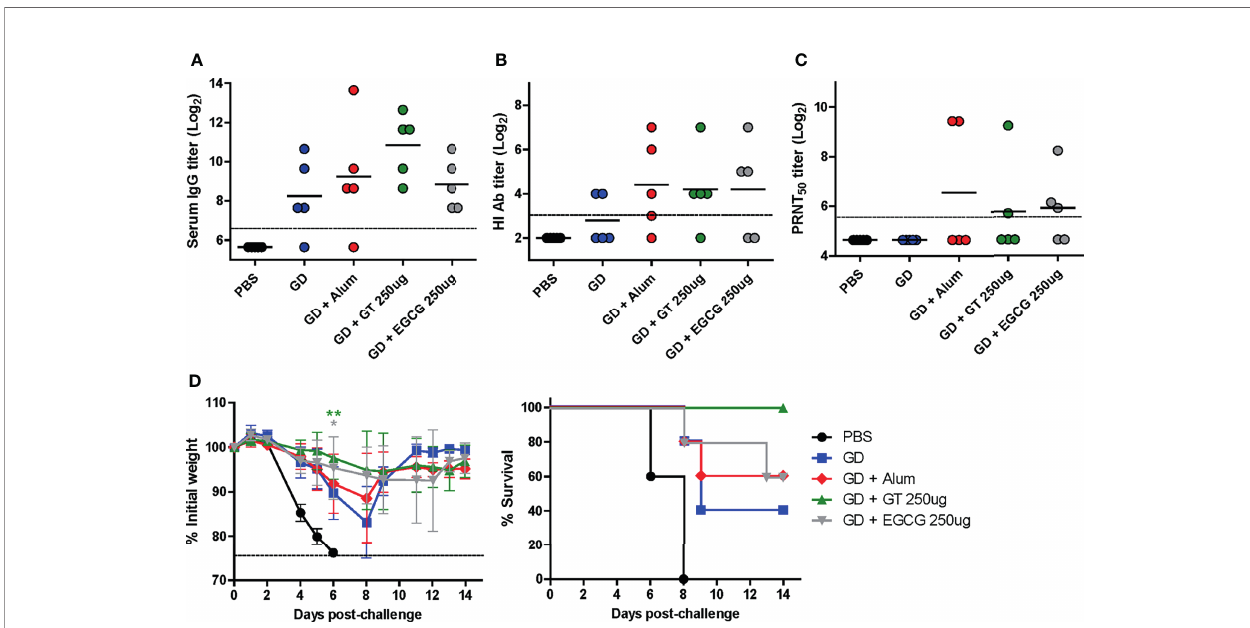
FIGURE 2 | Adjuvant effect of GT or EGCG on recombinant HA GD antigen. PBS or 10 µg of GD antigens with or without alum, GT, or EGCG were injected into mice via IM route thrice with the interval of two weeks. The overall experimental schedule was the same as presented in Figure 1B . (A) IgG antibody response to in fl uenza PR8 virus. The antibody titer of each sample was expressed as the endpoint dilution with an absorbance value 2× greater than that of the PBS control group. The detection limit (dashed line) was 100. (B, C) Neutralizing antibody responses to in fl uenza PR8 virus. HI antibody titers (B) and PRNT 50 titers (C) against the PR8 virus are shown. The detection limits of the HI assay and PRNT (dashed lines) were 8 and 50, respectively. (D) Protective ef fi cacy against in fl uenza PR8 virus. The vaccinated mice were challenged with 2 × 10 3 PFU (2 MLD 50 ) of wild type PR8 virus after the last vaccination, and the changes in weight and survival rates of the mice were monitored. Dashed line indicates humane endpoint which means losing 25% weight loss. Mice that lost >25% body weight were euthanized. Data of antibody titers (A – C) were log-transformed and expressed as means (horizontal lines) and scatter plots. Data of the changes in weight ( D , left panel) are shown as means (points) and standard deviations (error bars). Repeated measures two-way ANOVA followed by Bonferroni ’ s post-test was used to analyze weight changes for different mouse groups over time. Each group was compared with the group given the non-adjuvanted GD (** P < 0.01; * P <